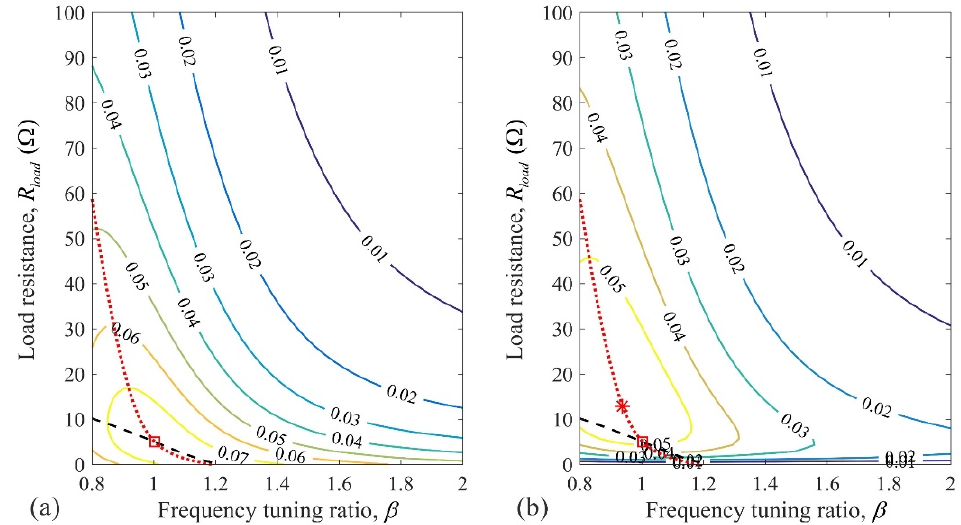
Figure 9. Contour plots of I 2 ( a ) and I 3 ( b ) superimposed with Equation (30)’s solution (black dashed line) and Equation (31)’s solution (red dotted line) when µ = 0.08 and ζ p =